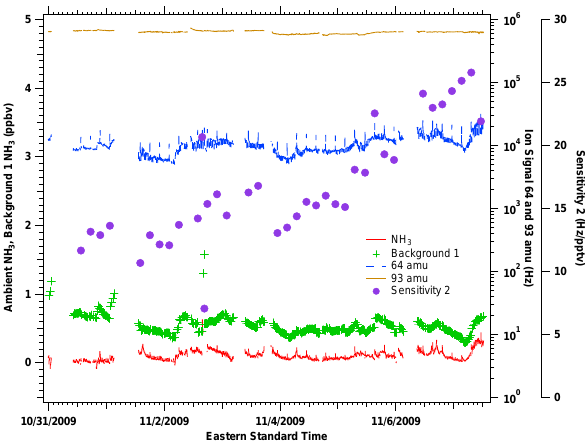
Fig. 5. Ambient measurements taken during the fall of 2009 over an 8 day span. Included are the main product (64amu, blue dashed line) and reagent ion mass signals (93amu, brown solid line), Back- ground 1 (green crosses) and Sensitivity 2 (purple closed circles), and the ambient [NH 3 ] (red solid